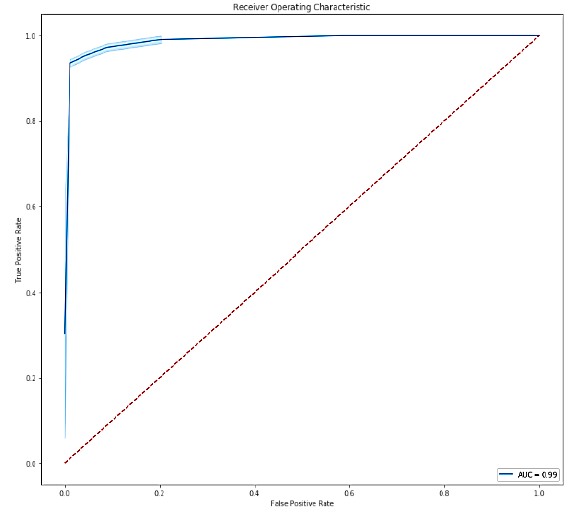
Figure 5. AUC curve LR model of selective